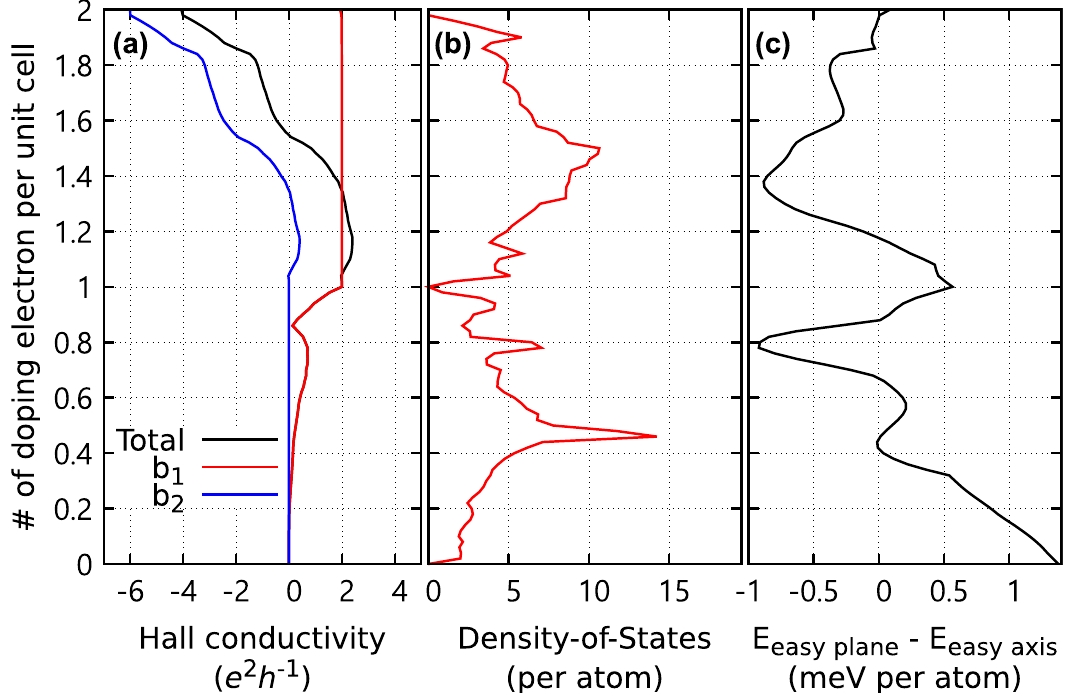
Fig. 4 Electron doping dependent AHC, DOS, and MAE. a AHC contributions for each band of Cr e g band manifolds from the lowest band ’ (red line), the second-lowest band ‘ b ’ (blue line), and the sum of two bands `Total' (black line), respectively. b The total density-of-states of ‘ b 1 2 Cr e g bands. Note that the results of panels ( a ) and ( b ) are obtained in the presence of the out-of-plane spin orientation. c The energy difference between easy plane and easy axis con fi gurations of ferromagnetic monolayer CrSiTe 3 .